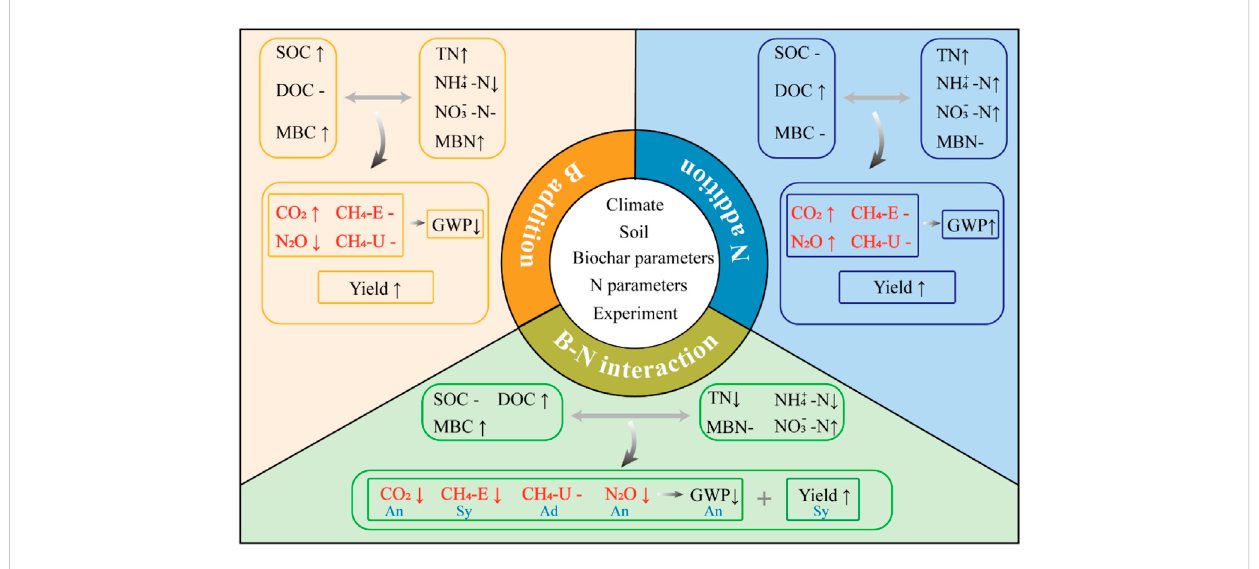
FIGURE 6 Potential mechanisms for the effects of biochar-N interactions on soil GHGs fl uxes. An, Sy, and Ad indicate antagonistic, synergistic, and additive,